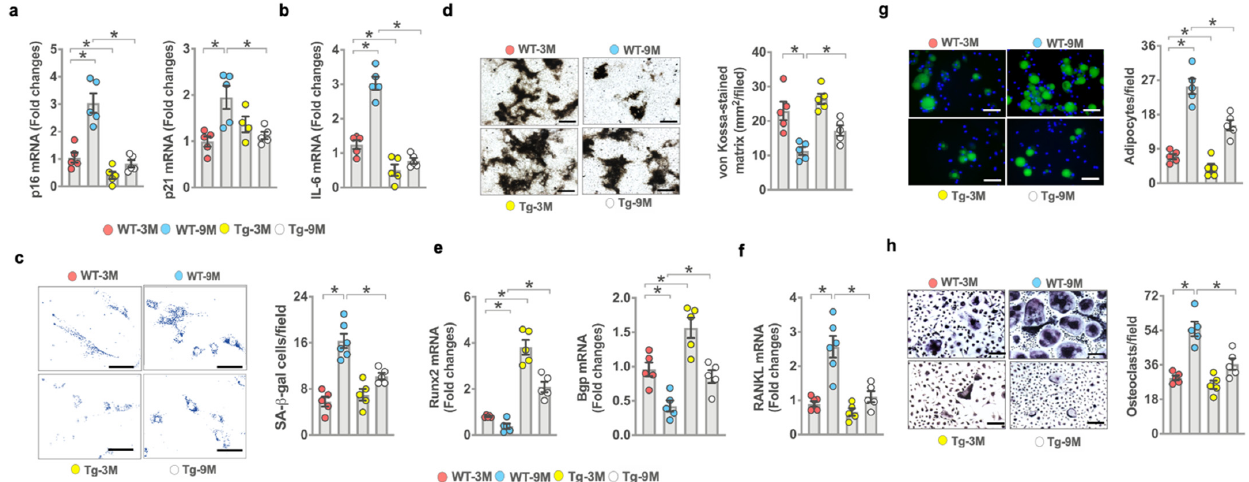
Figure 4. Effects of miR-29a overexpression on ex vivo osteogenic, adipogenic, and osteoclastogenic differentiation capacity. miR-29a repressed age-induced p16 , p21 ( a ), IL-6 expression ( b ), and SA- β -galactosidase activity of primary bone-marrow mesenchymal cells ( c ); scale bar, 20 μ m. miR-29a reversed age-induced loss in mineralized nodule formation ( d ) (scale bar, 40 μ m) and ( e ) Runx2 and Bgp expression ( e ) and decreased RANKL expression ( f ). miR-29a compromised ( g ) fluorescent Nile-red-stained adipocyte formation (scale bar, 20 μ m) and ( h ) TRAP-stained osteoclast formation (scale bar 20 μ m) in old mice. Significant difference (asterisks *) of investigations (mean ± standard error, n = 5) analyzed using an ANOVA test and a Bonferroni post hoc test.